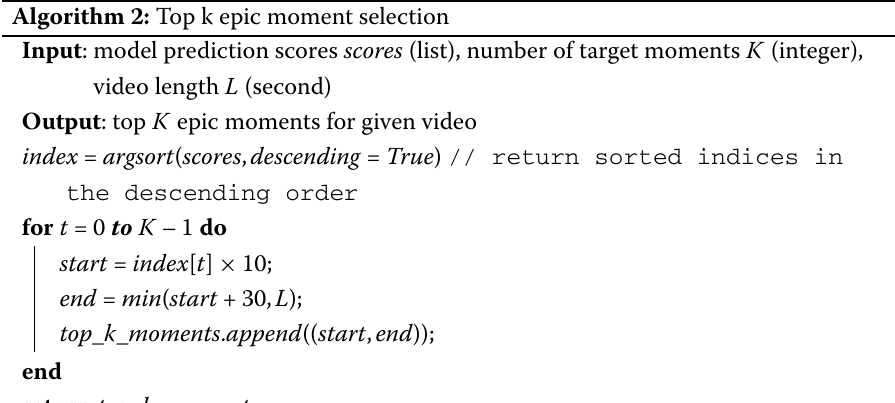
Algorithm 2: Top k epic moment